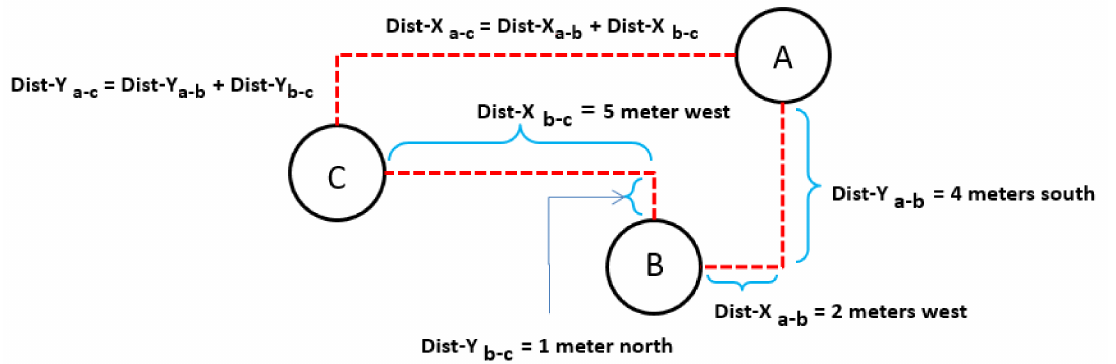
Figure 7. Relative localization of nodes in tier 2 and above w.r.t. the reference